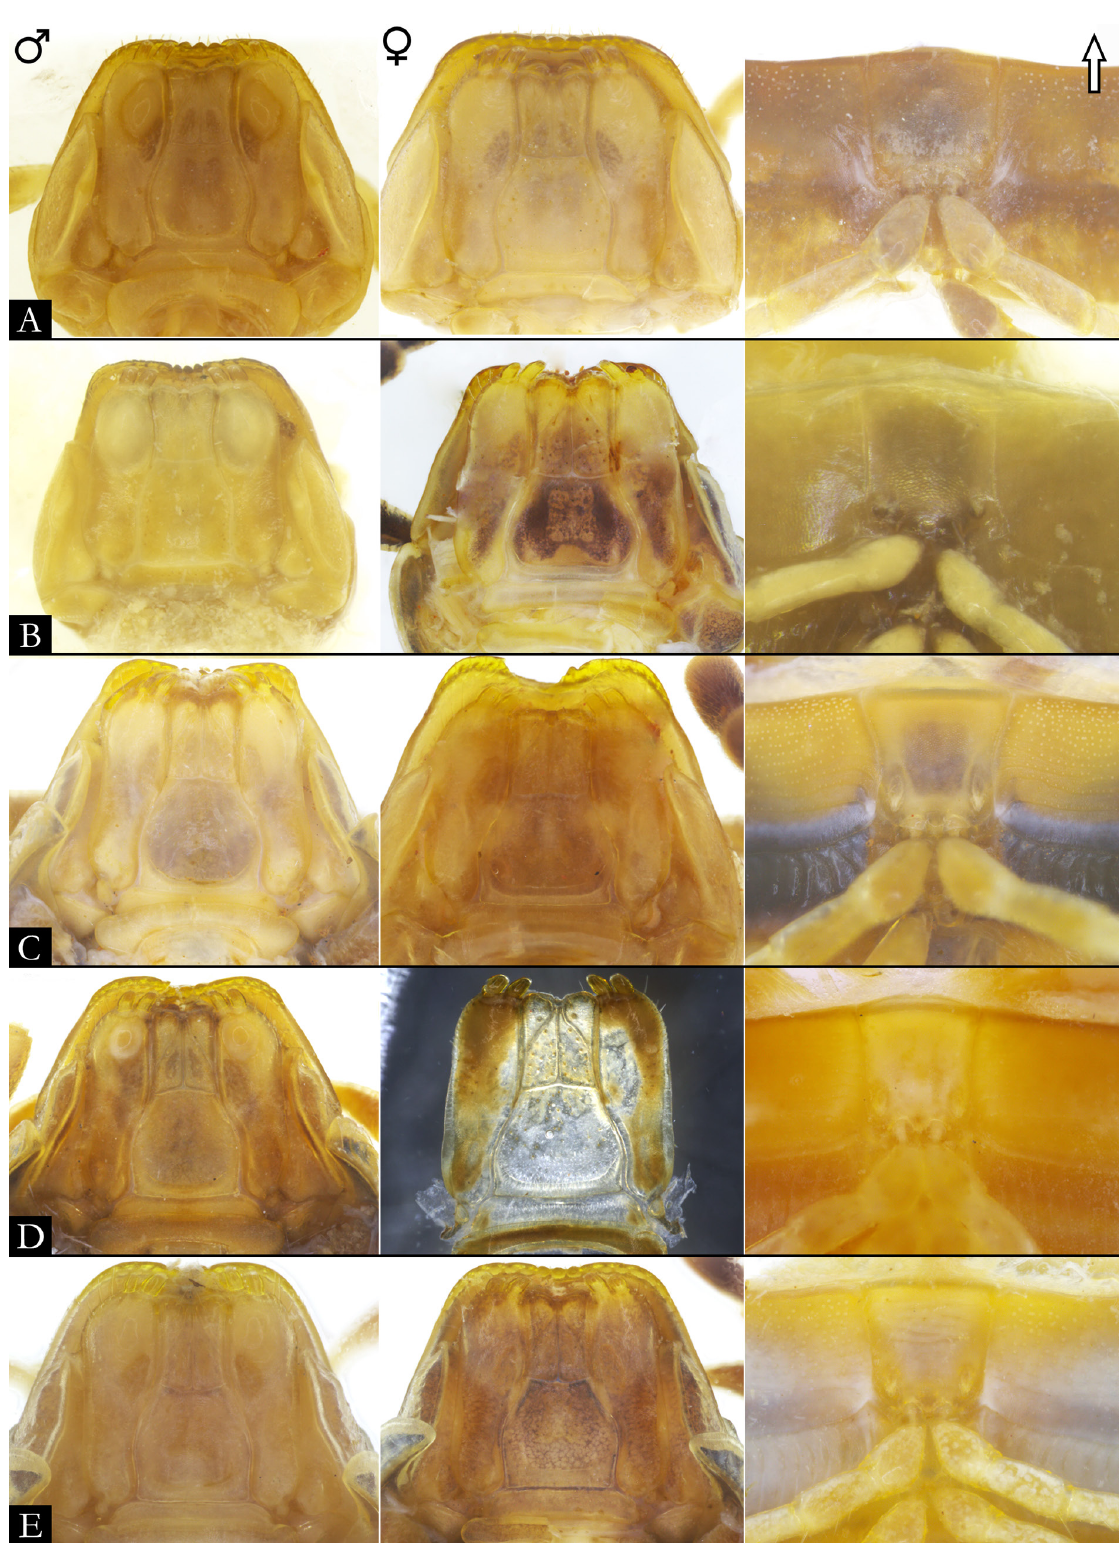
Fig. 173. Stereoscopic images of gnathochilarium and anterior sternum of species of